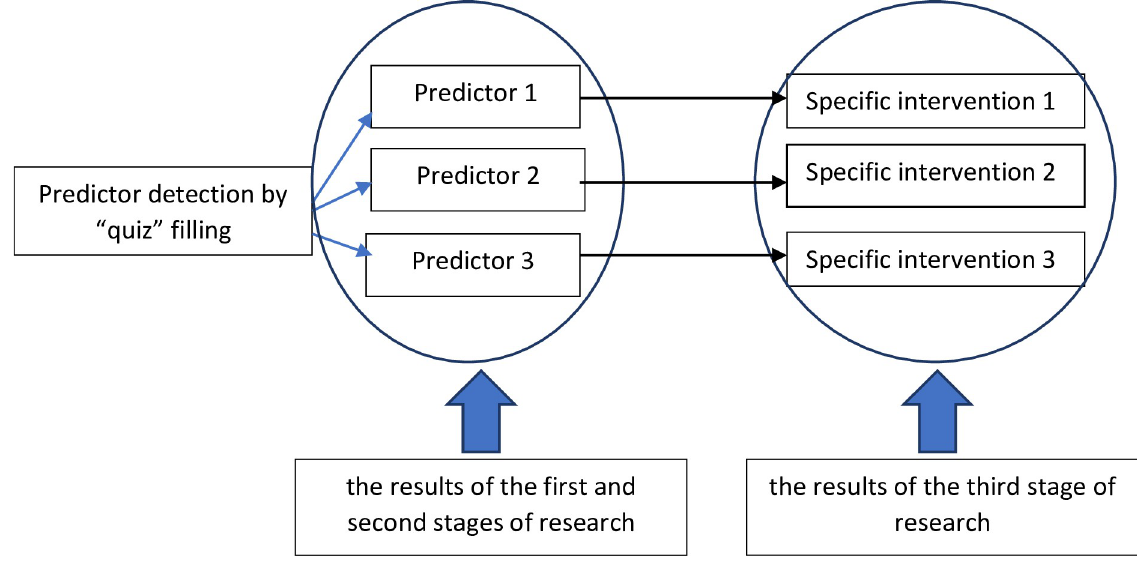
Fig 5. Development of specific intervention algorithm.